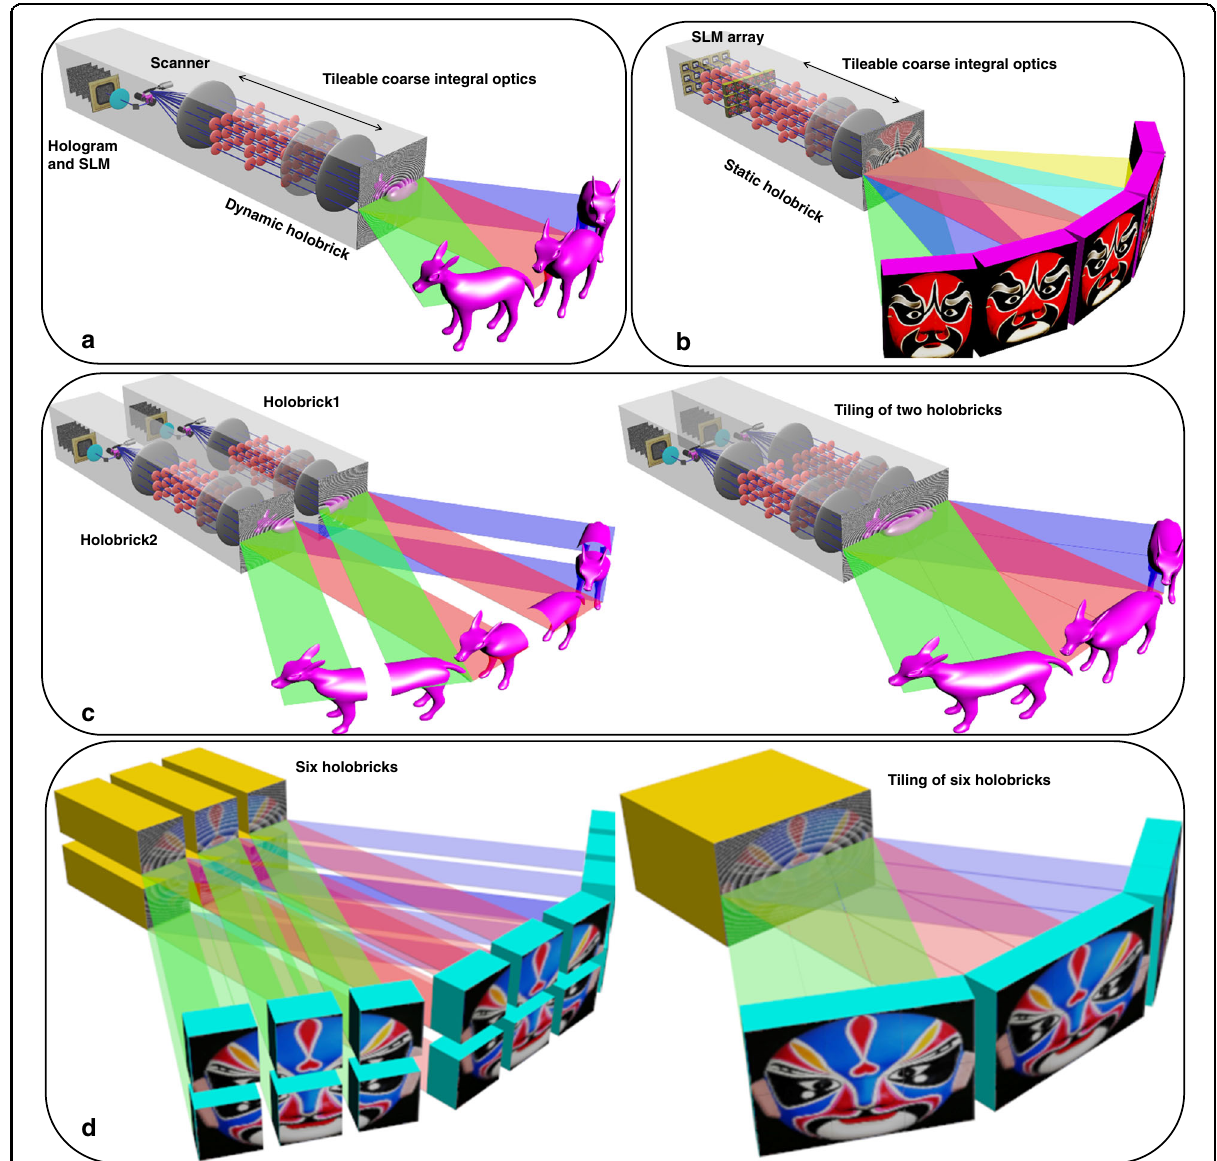
Fig. 1 Schematic of tileable holobricks. a Dynamic holobrick structure. b Static holobrick structure. c The spatial tiling of two dynamic holobricks. d The spatial tiling of six static/dynamic holobricks to display a large